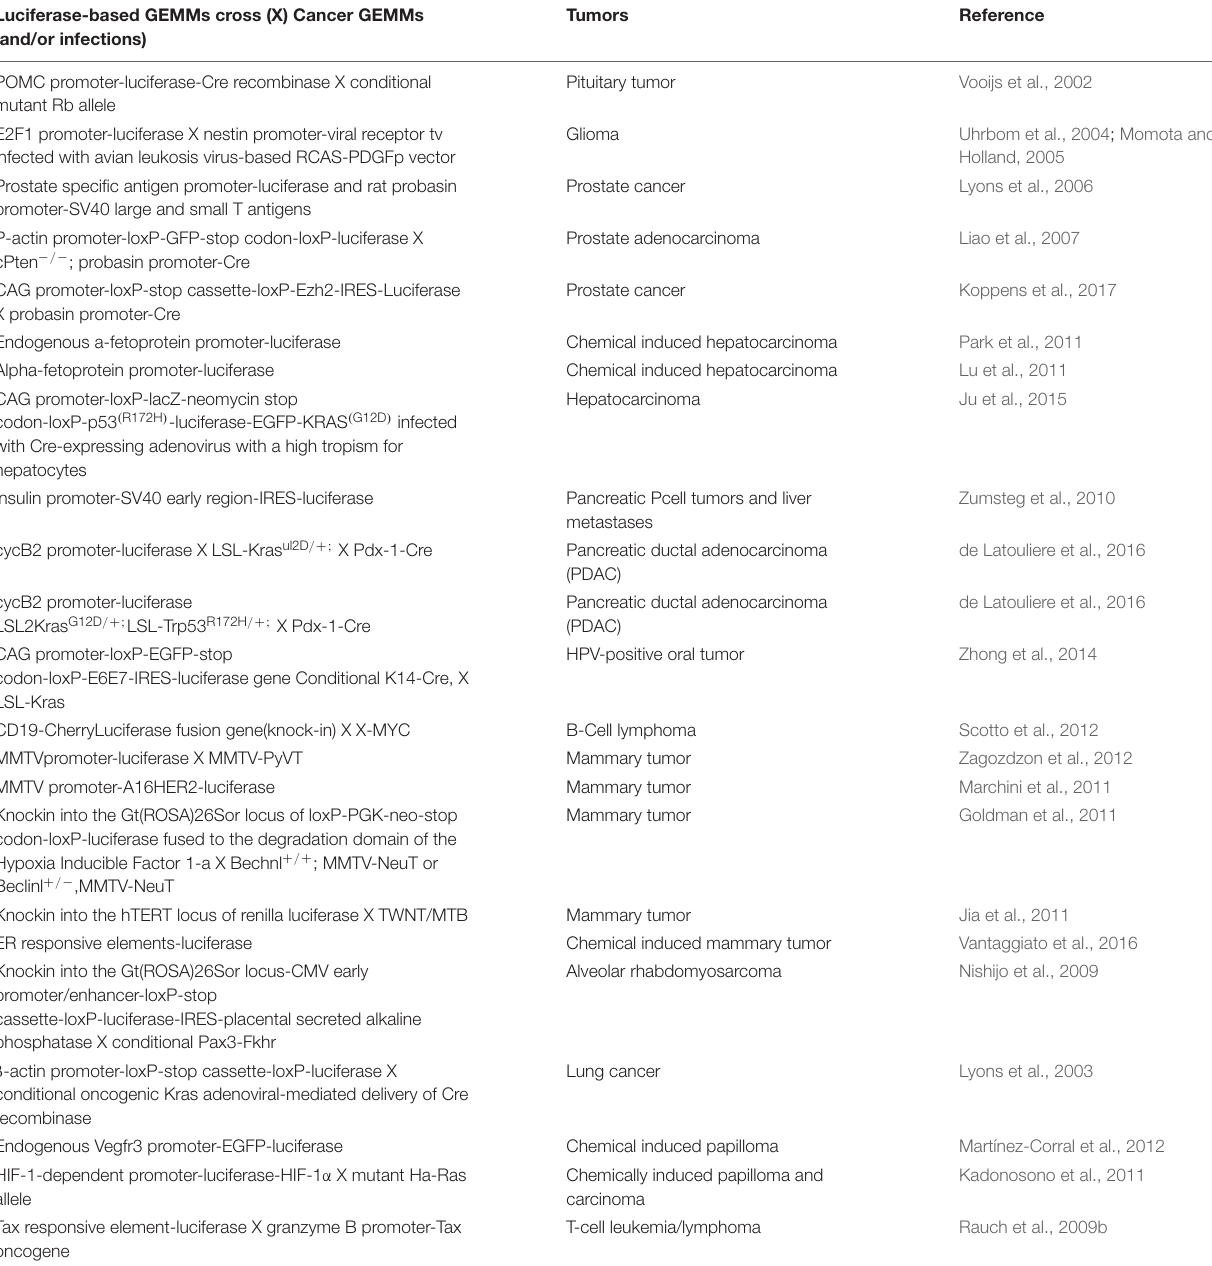
TABLE 2 | List of genetically engineered mouse models useful to illuminate cancers. Luciferase-based GEMMs cross (X) Cancer GEMMs (and/or